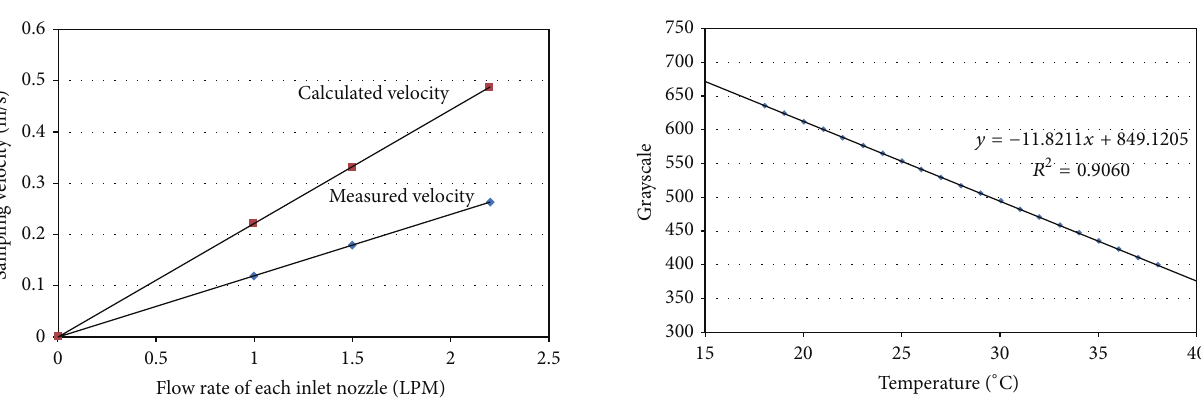
Figure 9: Comparison of the calculated velocity (area-averaged velocity at the inlet nozzle) and the measured velociy (maximum velocity downsteam of jets).